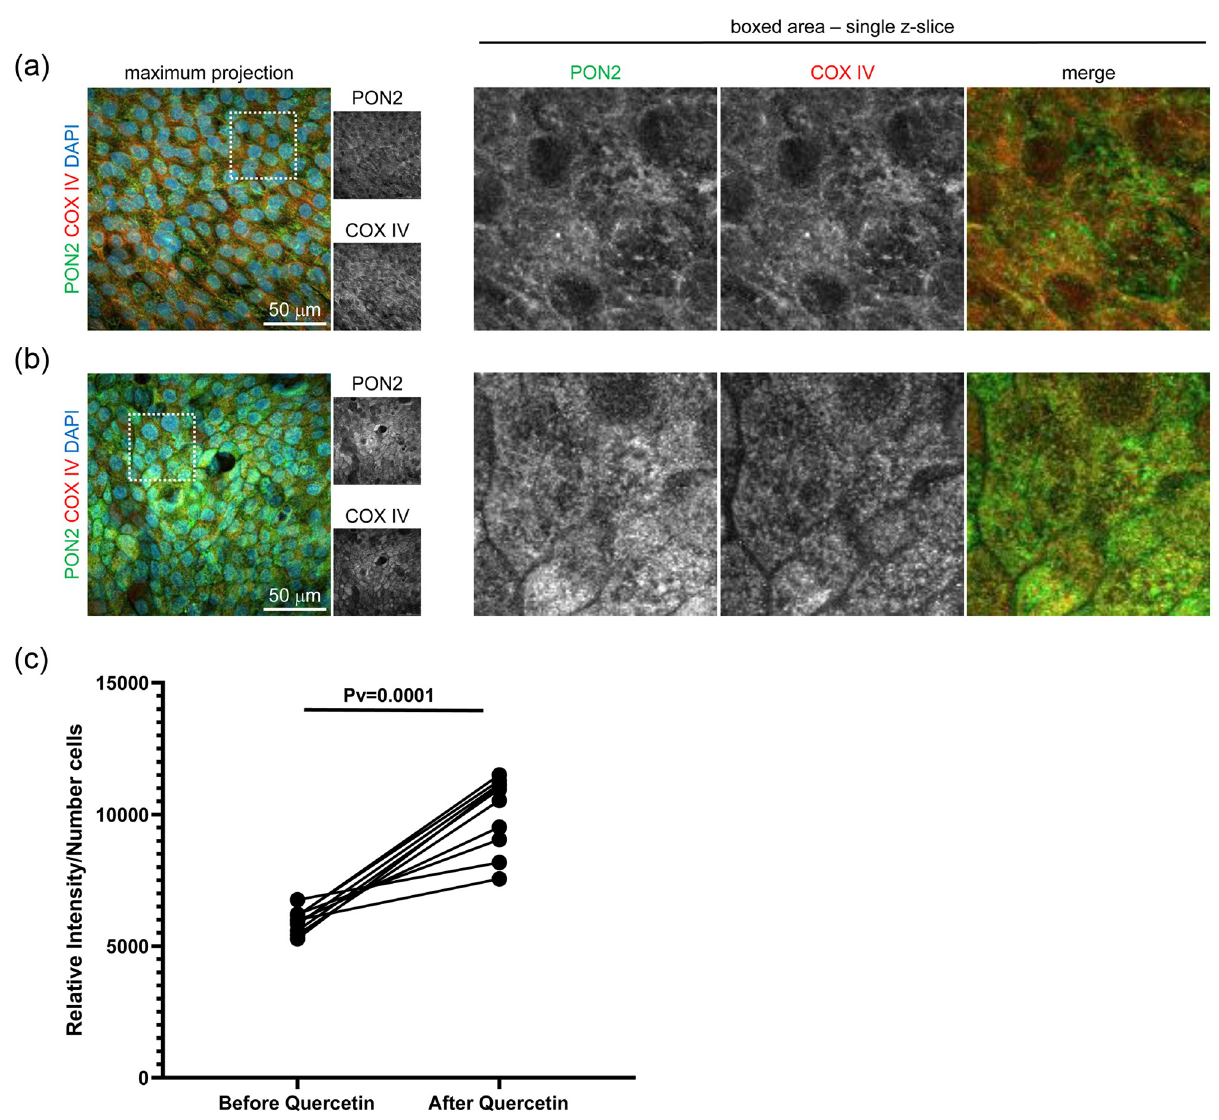
Fig 3. PON2 localization in HBECs. Maximum projection of confocal images stacks (left) of primary HBECs labeled with PON2 (green) and COX IV (red) antibodies and stained with DAPI to mark nuclei. PON2 localizes to mitochondria in primary human bronchial epithelial cells (a), Quercetin treatment does not shift PON2 mitochondria localization and increases its expression in human bronchial epithelial cells (b). Relative intensity of immunolabeling images showed that quercetin treatment on HBEC cultures increases approximately 50% PON2 protein levels (c).